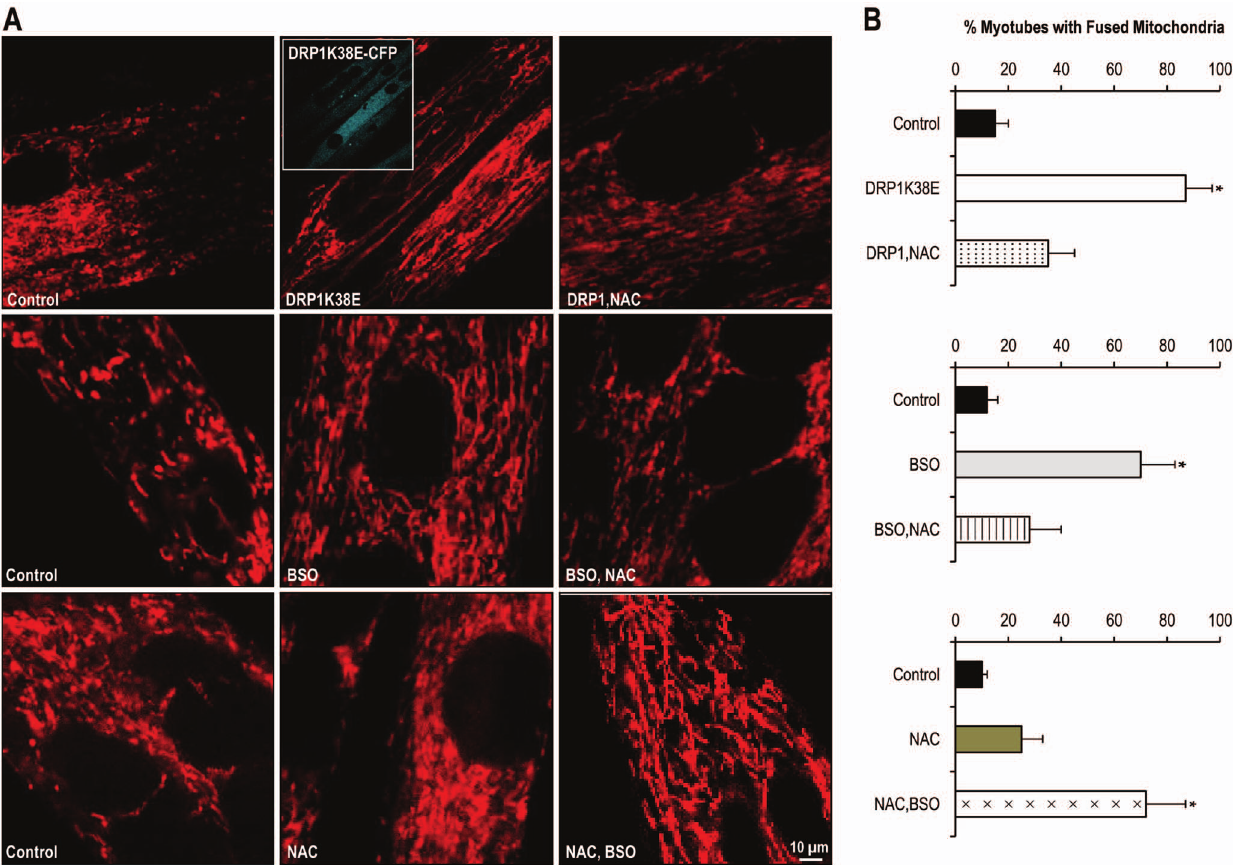
Figure 3. DRP1K38E expression and altered GSH synthesis modulate mitochondrial plasticity in C2C12 myotubes. C2C12 myoblasts were subjected to ‘‘forced fusion’’ or oxidative stress during differentiation. Panel A: Confocal microscopy images of C2C12 myotubes expressing DRP1K38E or treated with BSO, NAC or both. Panel B: Quantitative Analysis of mitochondria shape is illustrated on the right. 40 images per condition were acquired. Data are mean 6 SE. * Denotes p , 0.001 ANOVA, n=40 per group.